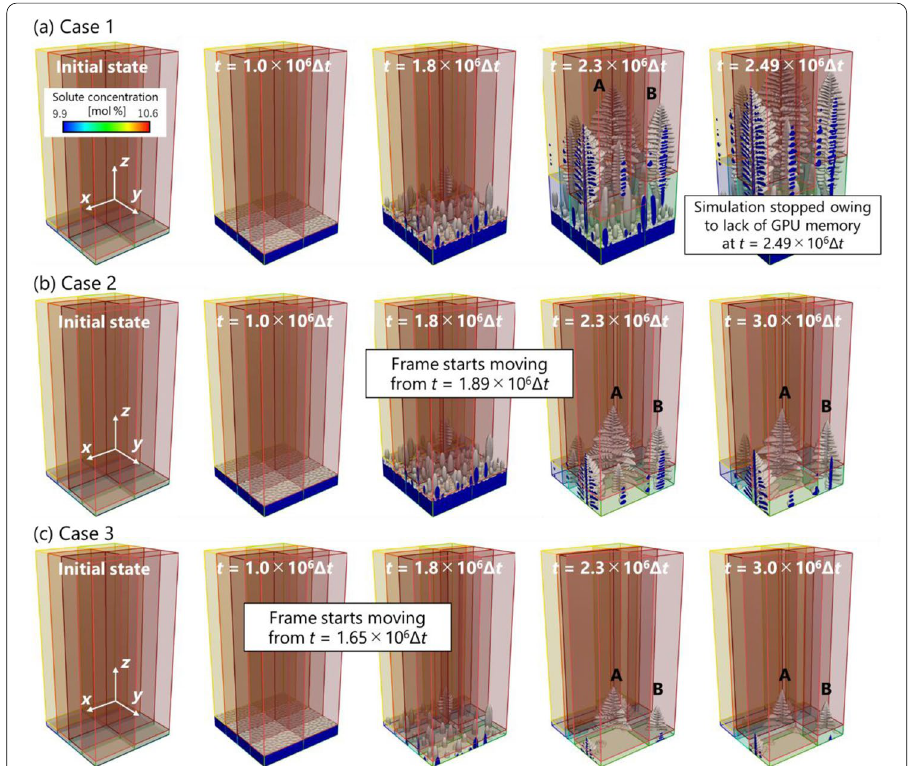
Fig. 6 Domain decomposition considering the dynamic load balancing for parallel computation using 16 GPUs during the directional solidification simulations shown in Fig. 5. In the simulations, the entire domain is divided into 2 4 2 subdomains in the x , y , and z directions. The outline of each subdomain is indicated by × × a different